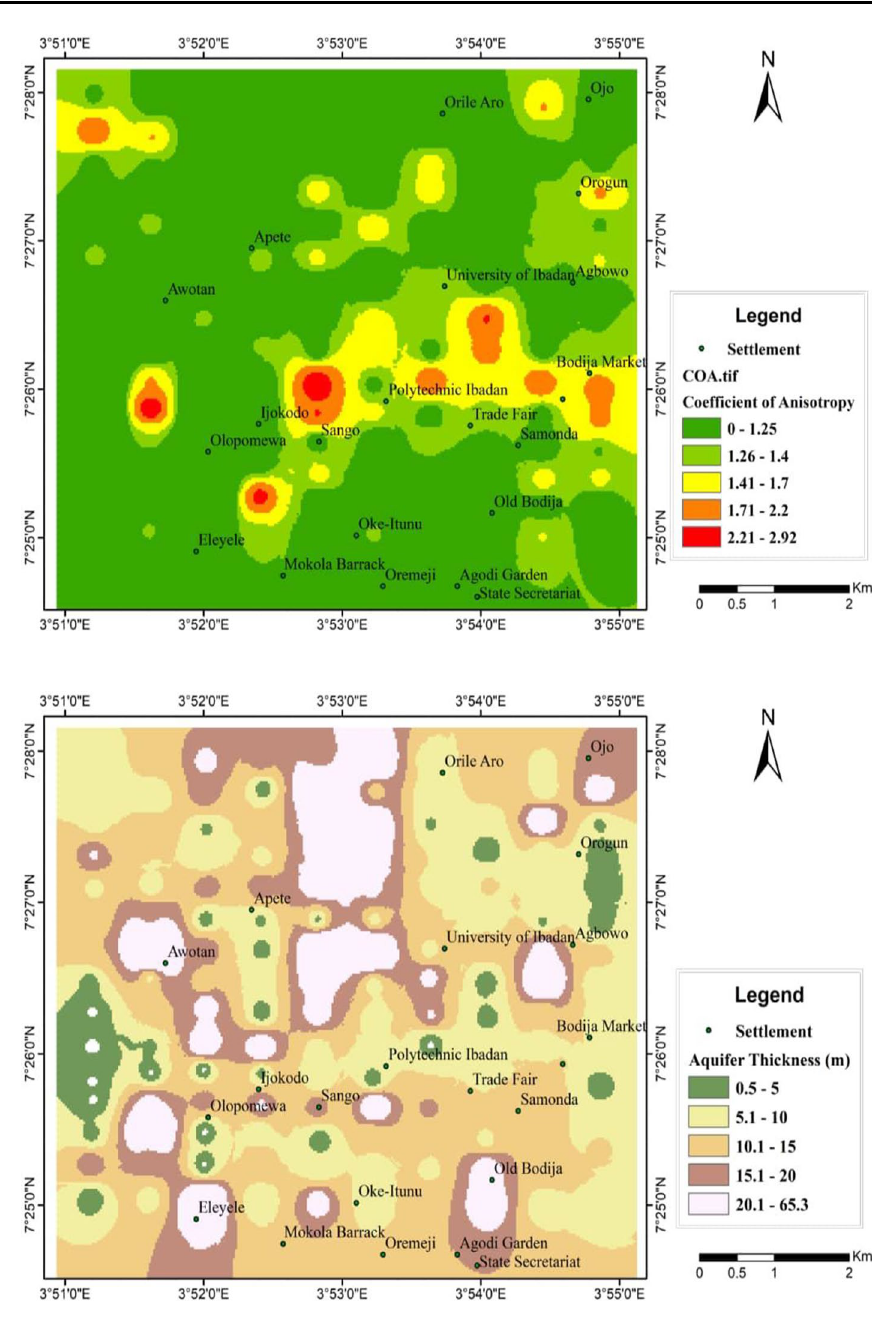
Fig. 10 Coefficient of anisot- ropy map of the study area